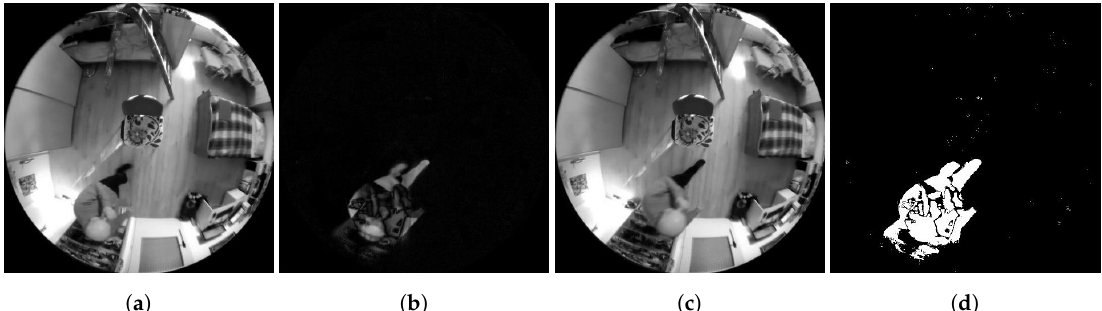
Figure 11. Examples of Method 2.1. functionality. ( a ) Background frame. ( b ) Difference in brightness between the currently checked frame and the background frame. ( c ) Currently checked